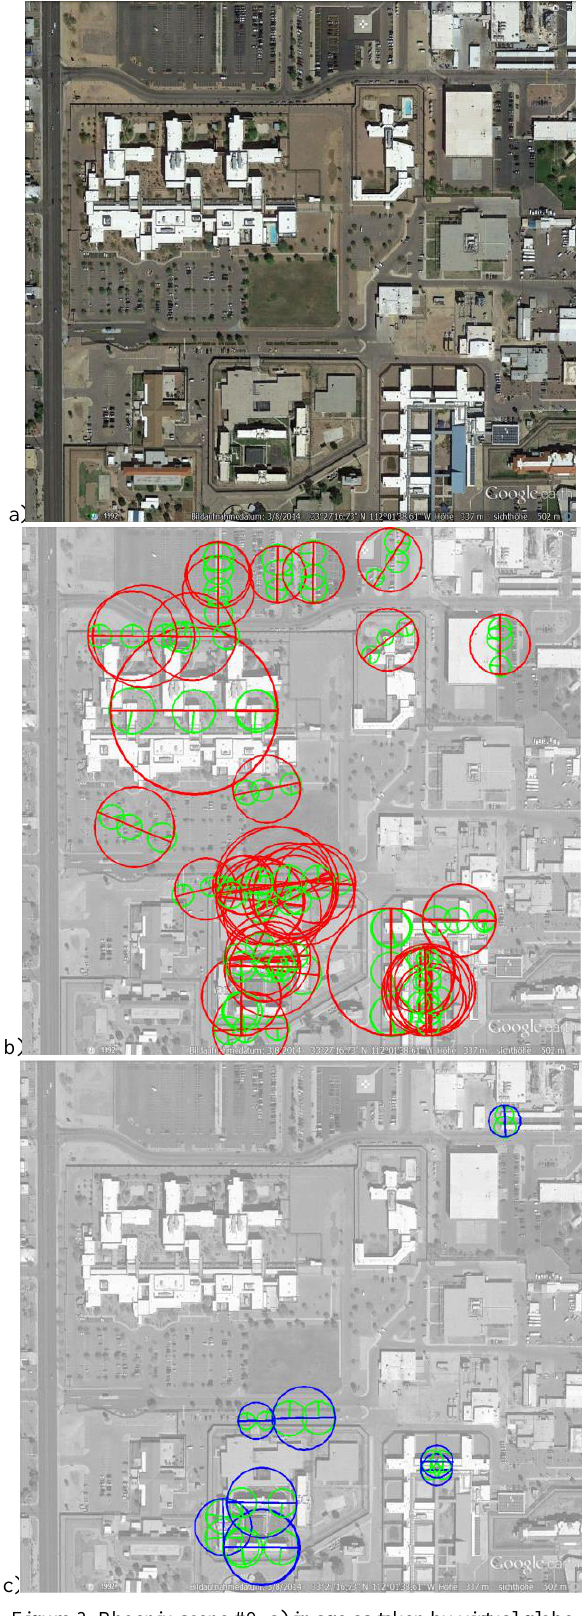
Figure 3. Phoenix scene #9: a) image as taken by virtual globe system; b) rows of primitive Gestalten ∑ P…P surpassing assessment 0.8; c) |-Gestalten on the same